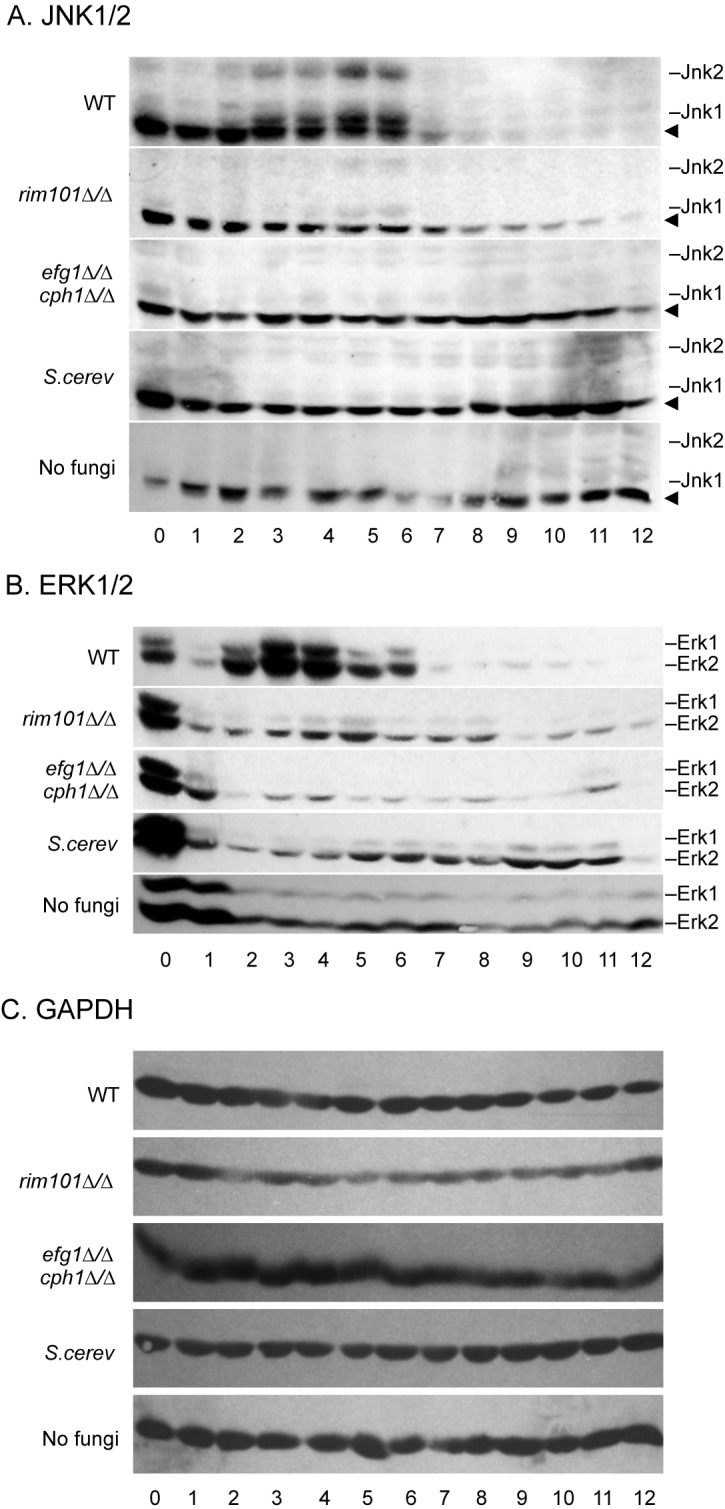
MAP kinase activation stimulated by C. albicans mutants.Total protein was purified from infected or non-infected FaDu epithelial cell monolayers at defined time points. Proteins were separated by SDS-PAGE and western blots probed with anti-phopho-JNK1/2 (A) or anti-phospho-ERK1/2 (B). A cross-reactive background band (arrowhead) was often observed with the anti-phospho-JNK1/2 antibody. Protein loading was normalized by detection of GAPDH (C). Results shown are representative of three independent experiments.